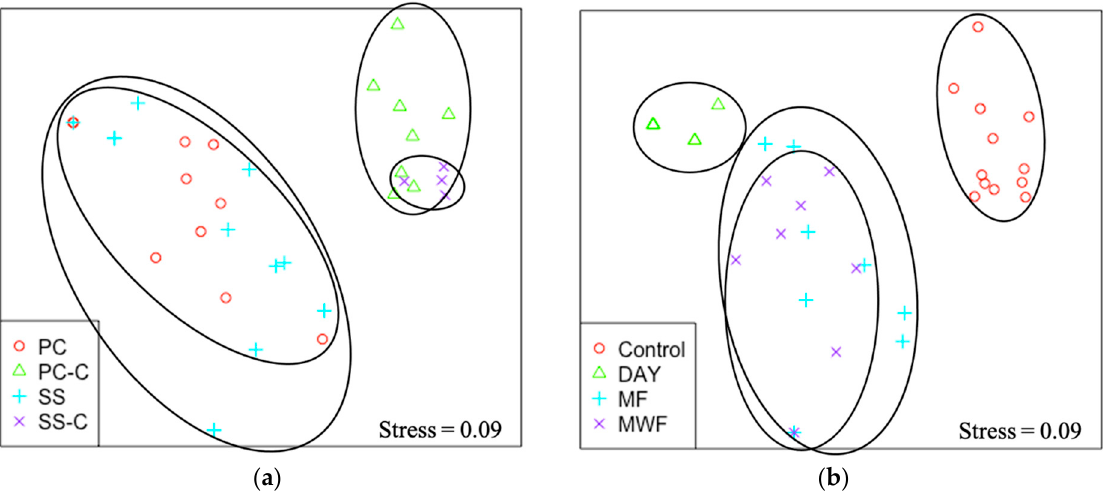
Figure 8. MDS of average biofouling communities among ( a ) polycarbonate (PC), stainless steel (SS), and nonexposed polycarbonate control (PC-C) and stainless steel control (SS-C), and ( b ) for the 10 min intervals: 10 min/day (Day), 10 min twice weekly (MF), 10 min three times weekly (MWF).